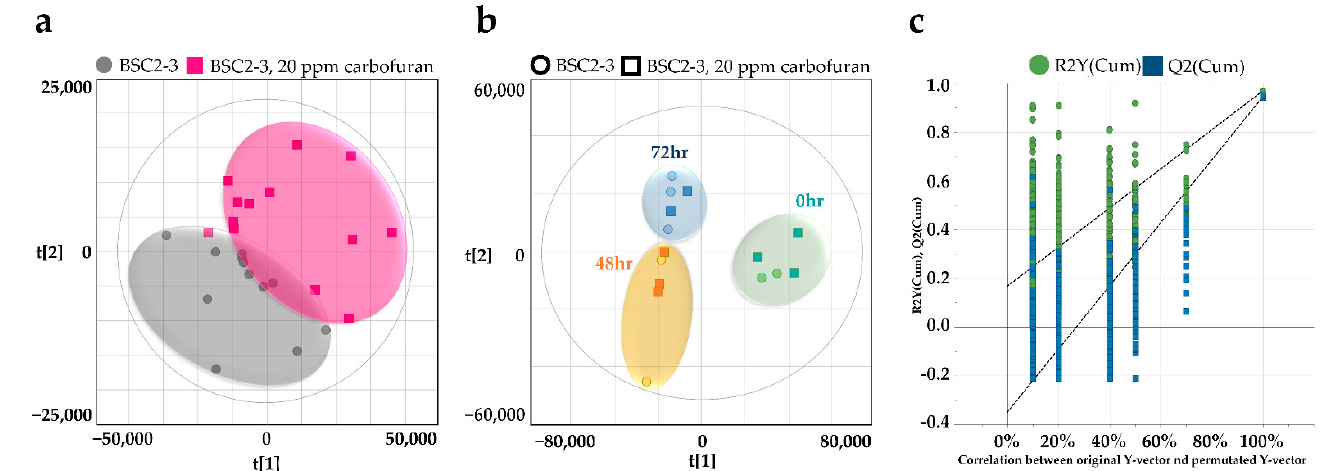
Figure 3. Multivariate analysis of intracellular metabolites from Chryseobacterium sp. BSC2-3. ( a ) PLS-DA score scatter plot derived from a total of 299 metabolites between two groups and ( b ) considering the time-dependent effect. ( c ) Validation plot using 999 permutation tests for all samples (R2 was lower than 0.4, and the intercept of Q2 was lower than 0.05).